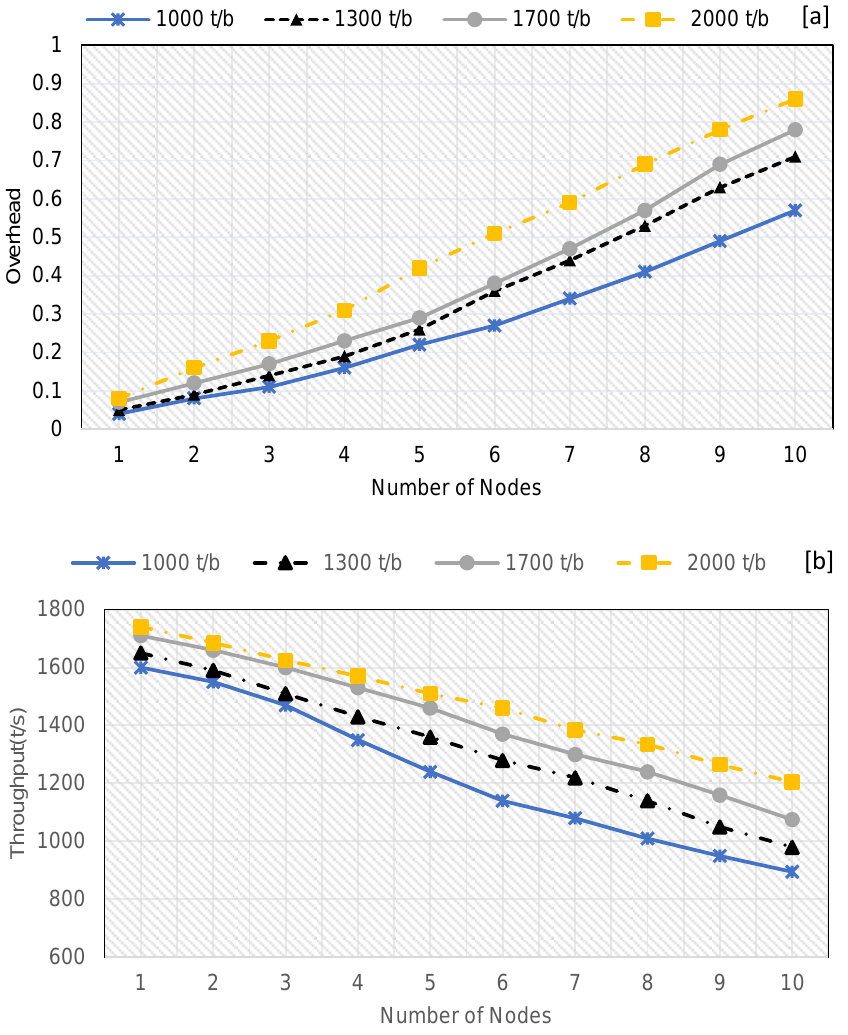
Figure 8. ( a ) Overhead and ( b ) Throughput of proposed private blockchain with a various number of transactions.